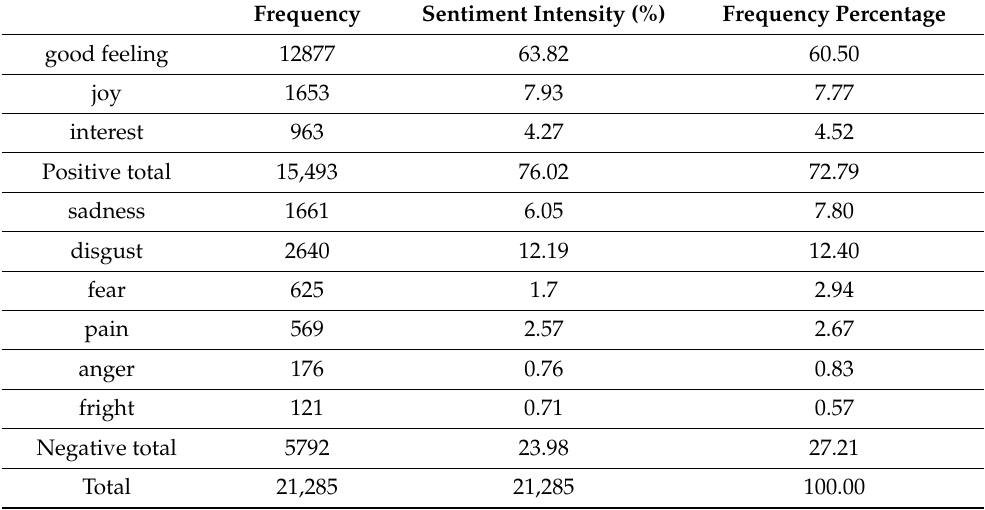
Table 11. Sentiment analysis of food delivery